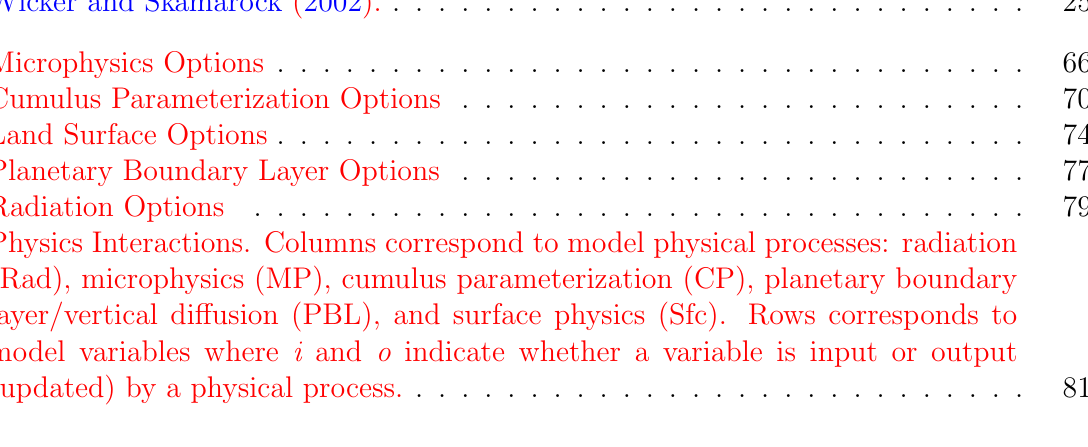
Physics Interactions. Columns correspond to model physical processes: radiation (Rad), microphysics (MP), cumulus parameterization (CP), planetary boundary layer/vertical diffusion (PBL), and surface physics (Sfc). Rows corresponds to model variables where i and o indicate whether a variable is input or